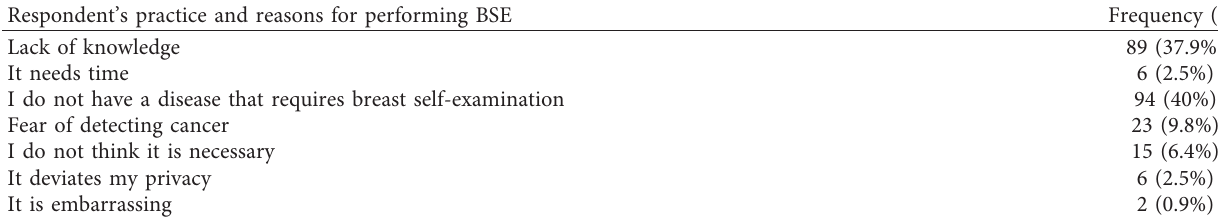
Table 4: Barriers toward performing BSE.